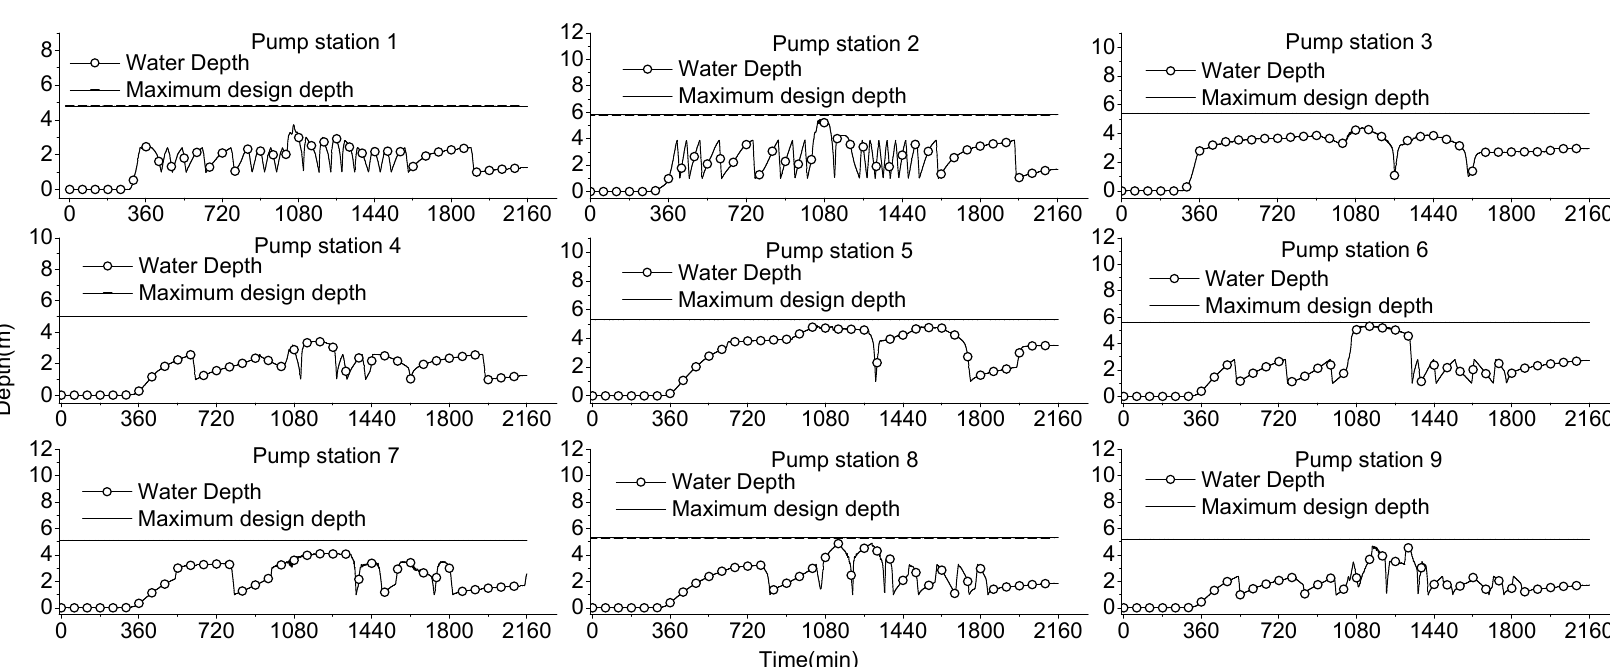
Figure 6. Water depth changing process in the storage tanks for the multistage pumping station optimization in the twenty-year scenario.